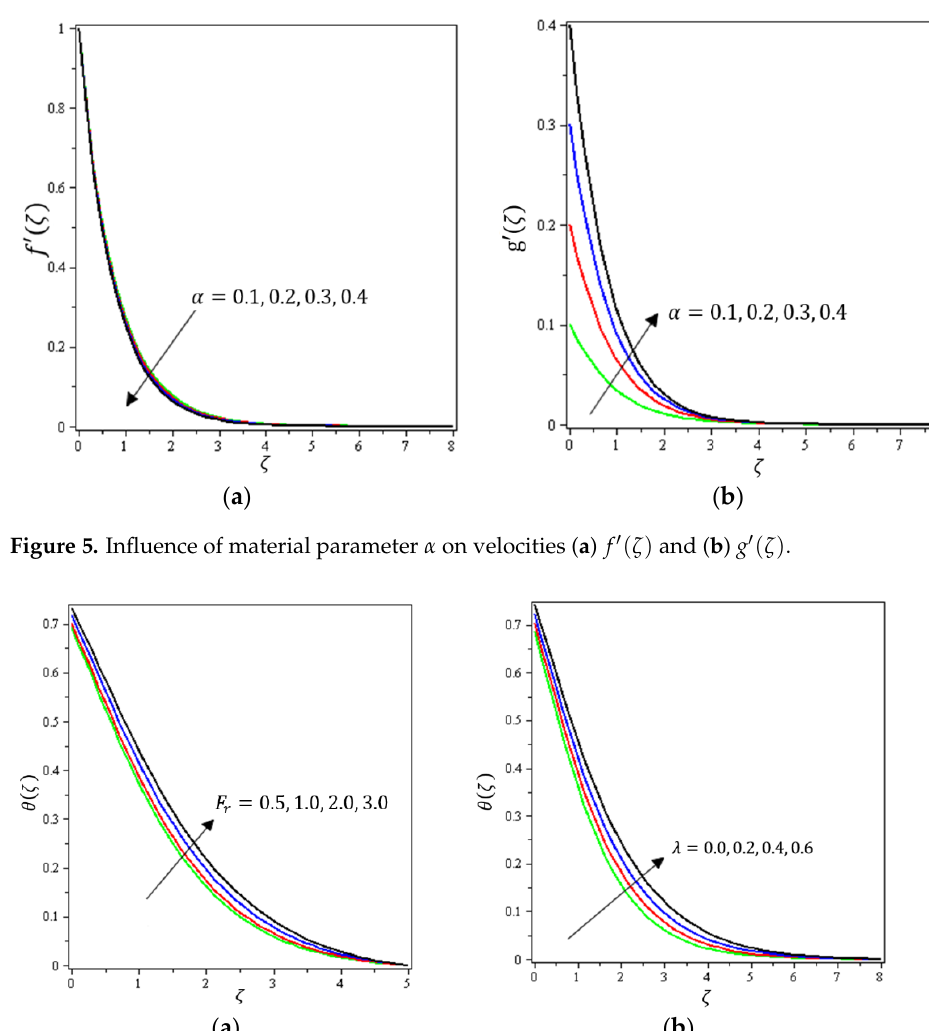
( b ) Figure 3. Influence of Darcy–Forchheimer number 𝐹 (cid:3045) on velocities ( a ) 𝑓′(𝜁) and ( b ) g ′(𝜁) .